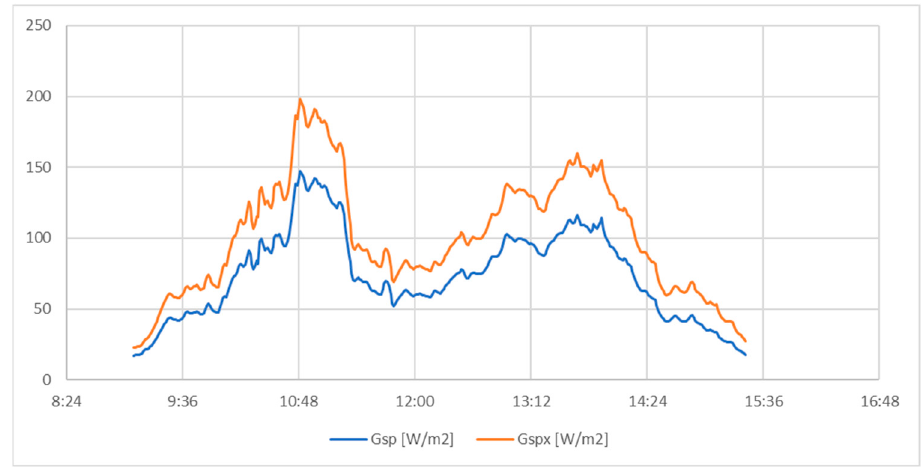
Figure 3. G SP and G SPX waveforms for heavy clouds.